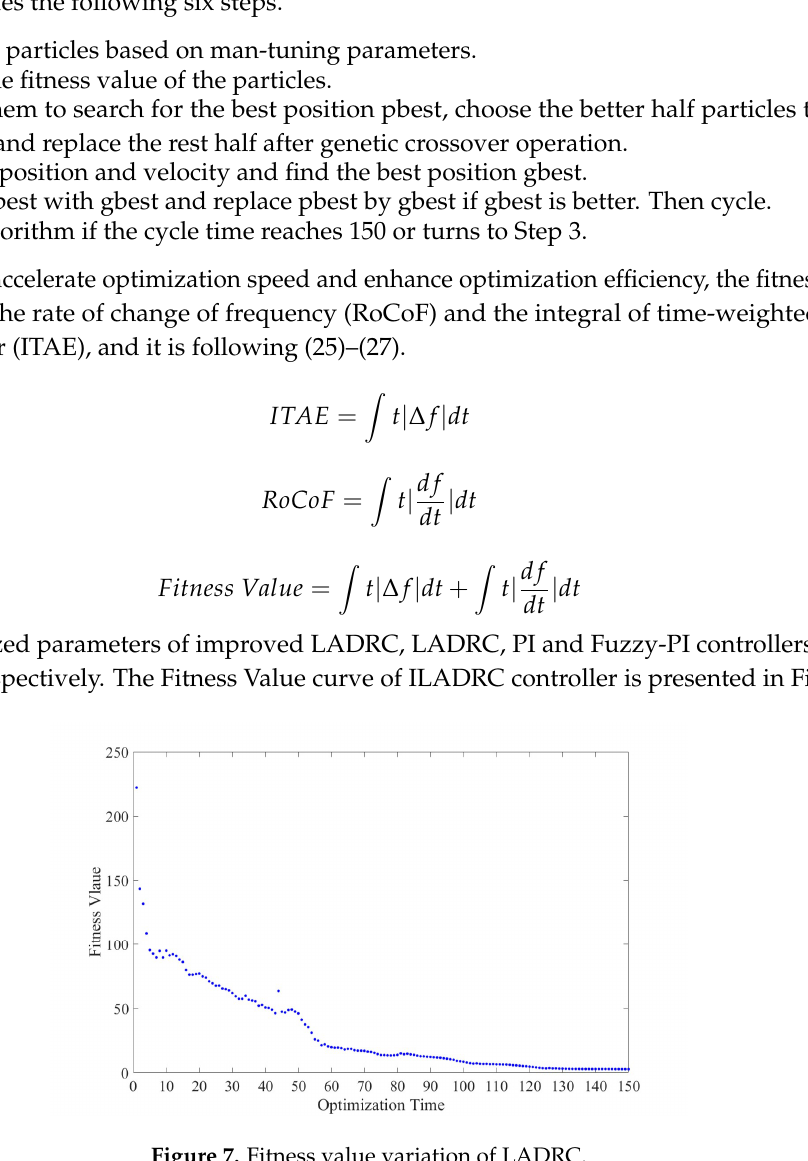
Figure 7. Fitness value variation of